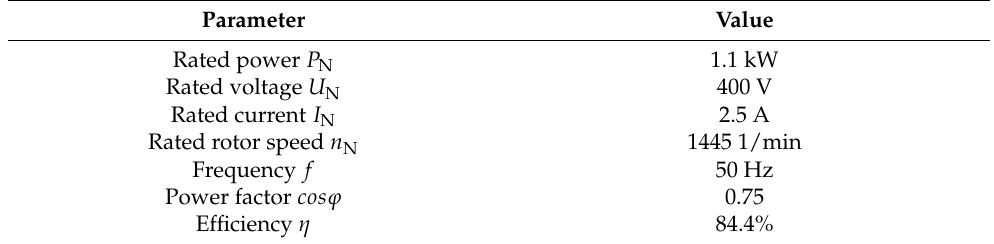
Table 1. Nameplate data of the examined 1.1 kW squirrel cage induction motor for a delta